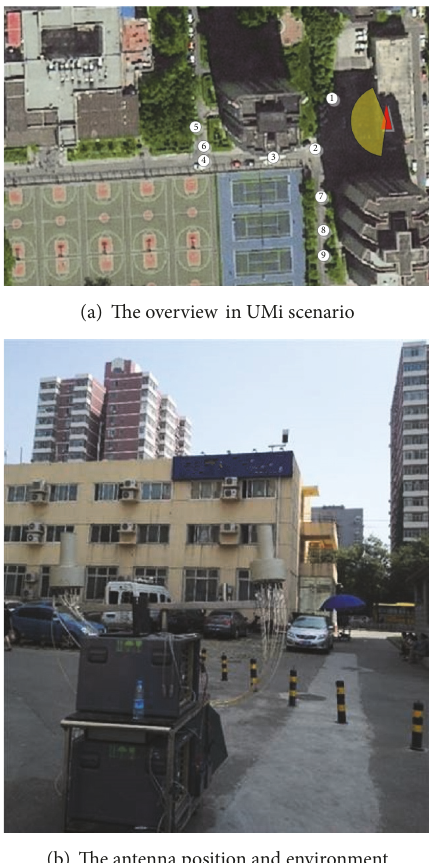
Figure 2: The overview of the measurement area by Baidu Map and the setup position of Tx and Rx